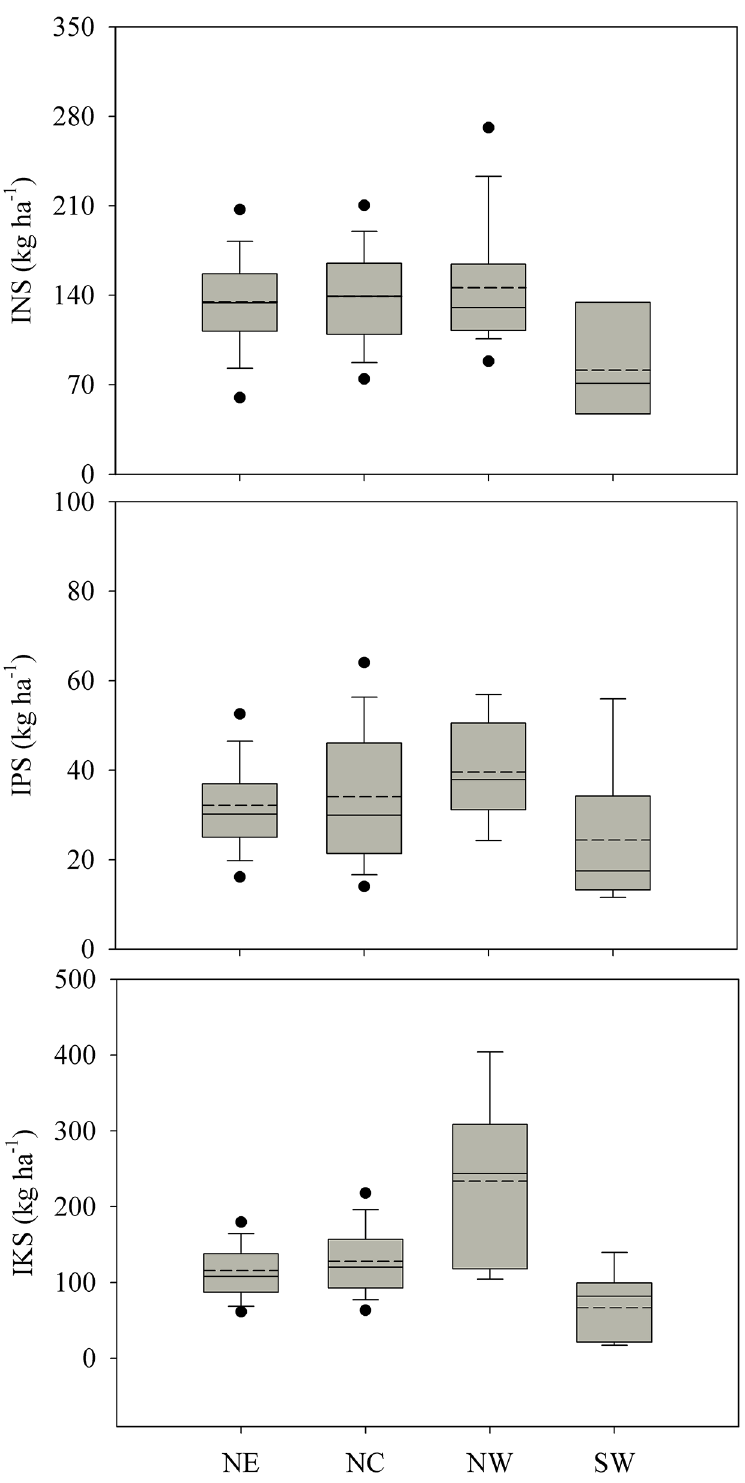
Fig 3. Variation in the indigenous nutrient supply for maize in Northeast (NE), North-Central China (NC), Northwest (NW) and Southwest (SW); INS, IPS, and IKS indicate indigenous N, P, and K nutrients supply, respectively. Solid and dashed lines indicate median and mean, respectively. The box boundaries indicate the upper and lower quartiles, the whisker caps indicate the 90 th and 10 th percentiles, and the circles indicate the 95 th and 5 th percentiles. Numbers in brackets denote the number of